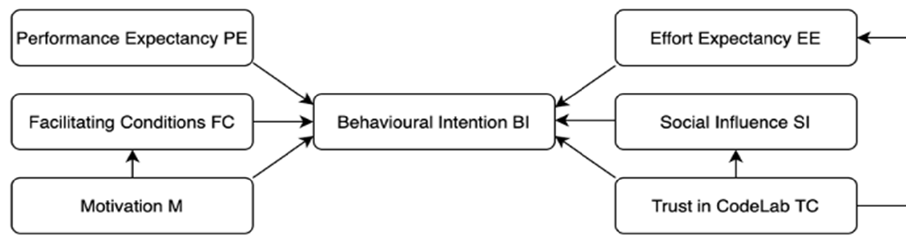
Figure 2. Model adapted from [45].